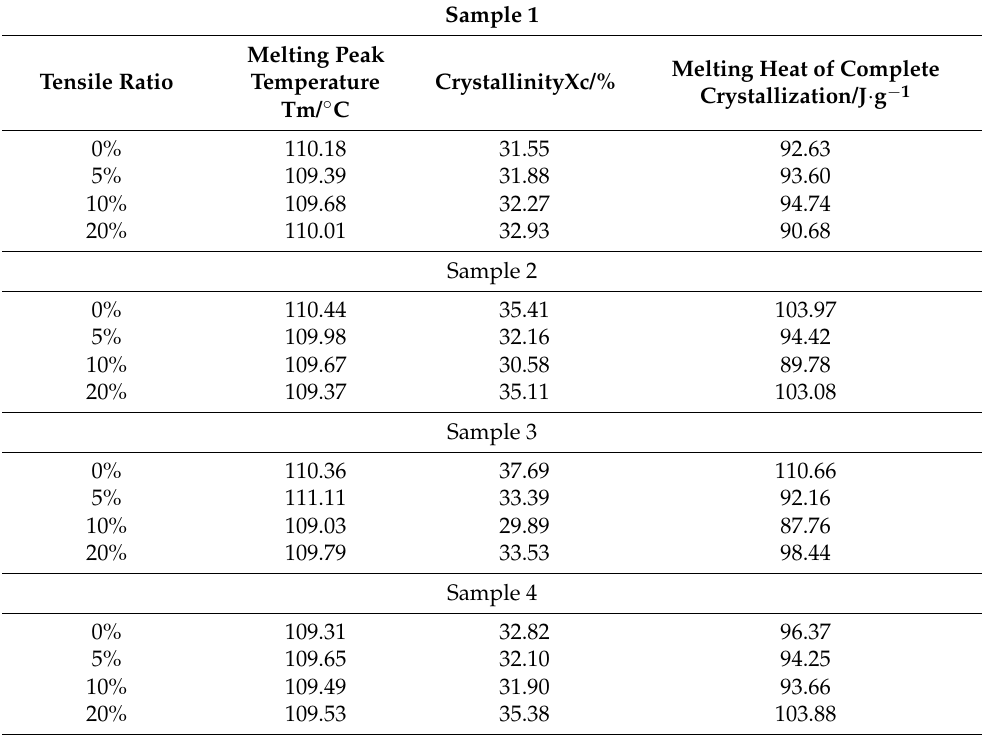
Table 2. Melting peaks and crystallinities of all samples. Sample 1 Melting Tensile Ratio